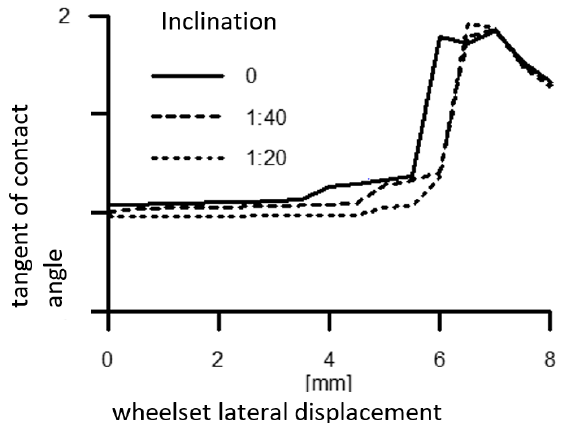
In this case, for most of the possible relative positions of the wheelset and the rails, we have one-point contact. The fact of changing the position of contact points entails changes in the geometric parameters of the contact, which we will show in the example of changes in the rolling radius and contact angle, assuming the symmetry of wheel and rail profiles for both rails of the track and a track width equal to 1435 mm. Figure 12 shows a comparison of the course of the tangent value of the contact angle between the wheel and rail for three previously analyzed rail inclinations They are presented as functions of lateral displacements of the wheelset within the range from 0 to 8 mm. The course of tangent values of the contact angle for 0 inclination grows the fastest. The values obtained for inclinations equal to 1:20 and 1:40 almost coincide for larger displacements of the wheelset. The course for 1:40 inclination is slightly bigger for smaller displacements.